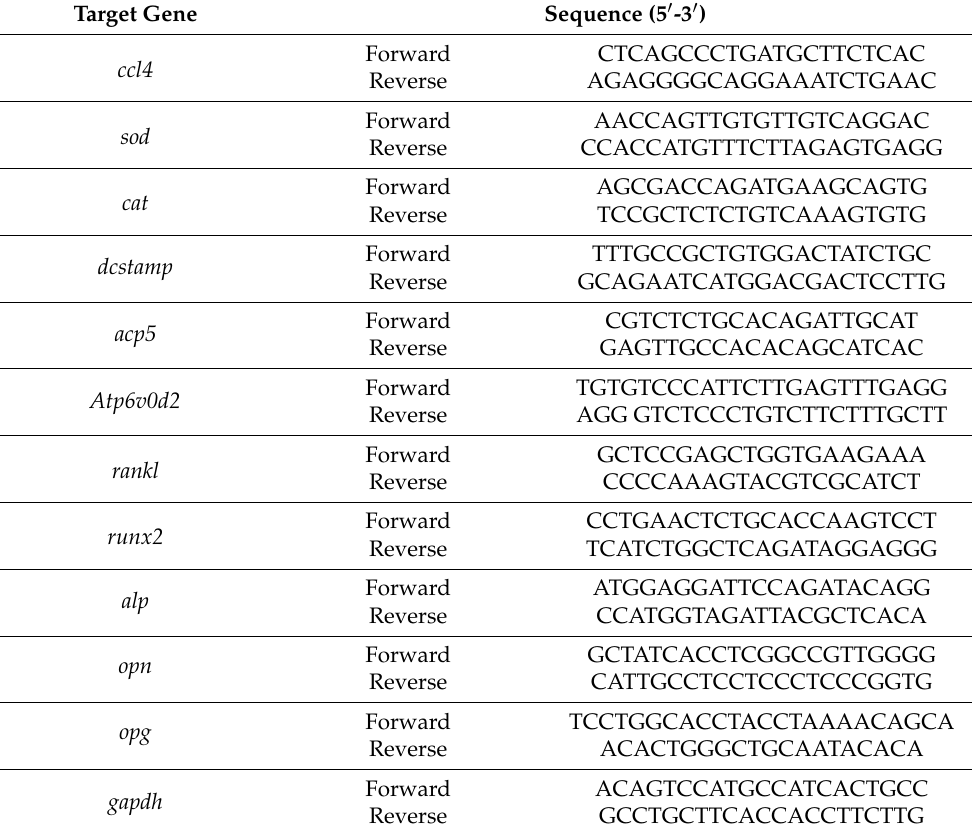
Table 2. Primer sequences of Real-time quantitative PCR analysis. Target